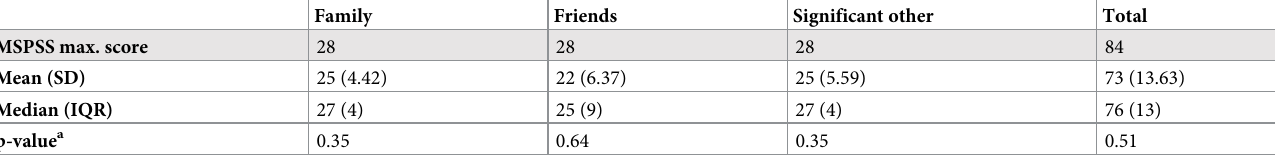
Table 5. Multidimensional Score of Perceived Social Support (MSPSS) of breast cancer